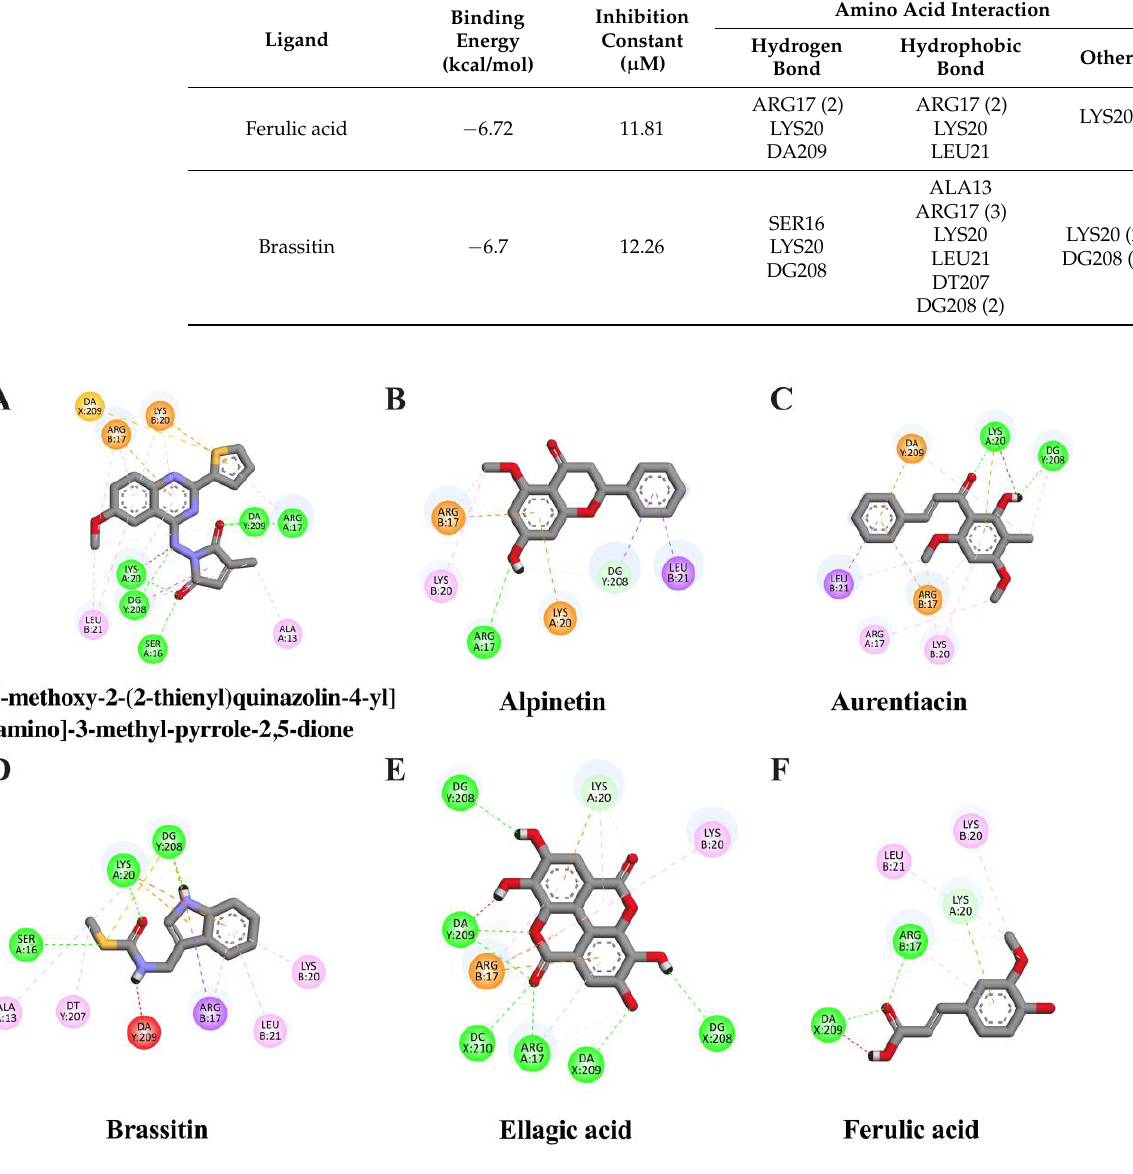
Figure 3. Schematic interactions of amino acid residues between reference inhibitor or candidate compounds and AP-1 protein. The original inhibitor of AP-1 protein is ( A ) 1-[[6-methoxy-2-(2- thienyl)quinazolin-4-yl]amino]-3-methyl-pyrrole-2,5-dione and candidate ligands are as follows: ( B ) alpinetin, ( C ) aurentiacin, ( D ) brassitin, ( E ) ellagic acid, and ( F ) ferulic acid. The green dashed line represents hydrogen, the pink or purple dashed lines represent hydrophobic bonds, and the yellow dashed line indicates other bonds.